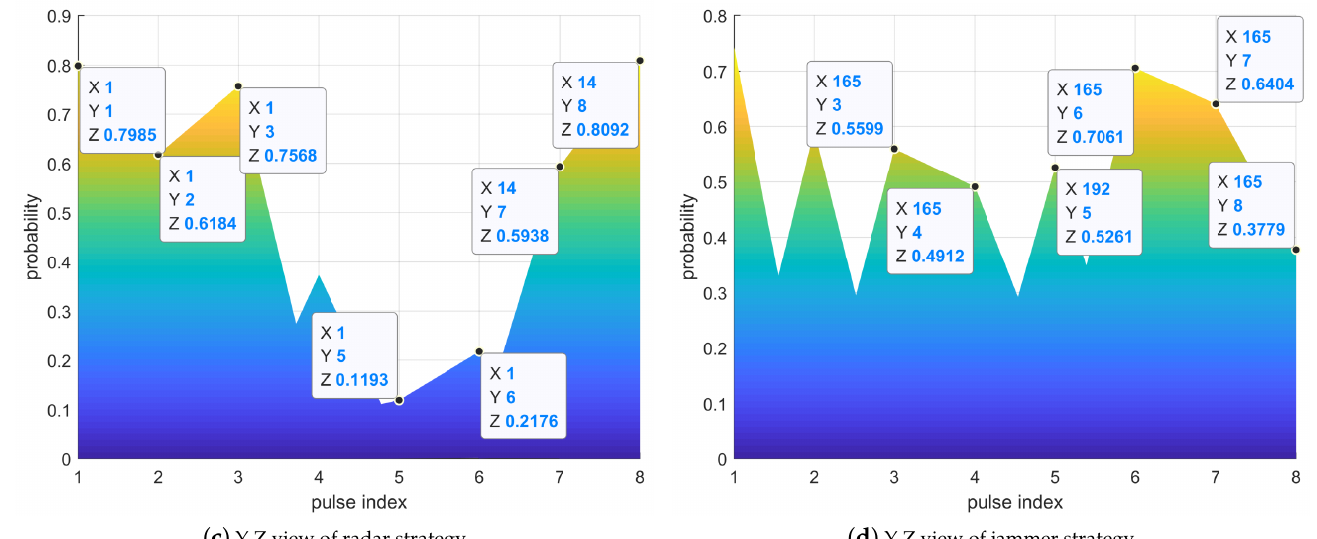
Figure 10. Approximate NE strategies with a quantization step of 0.1.